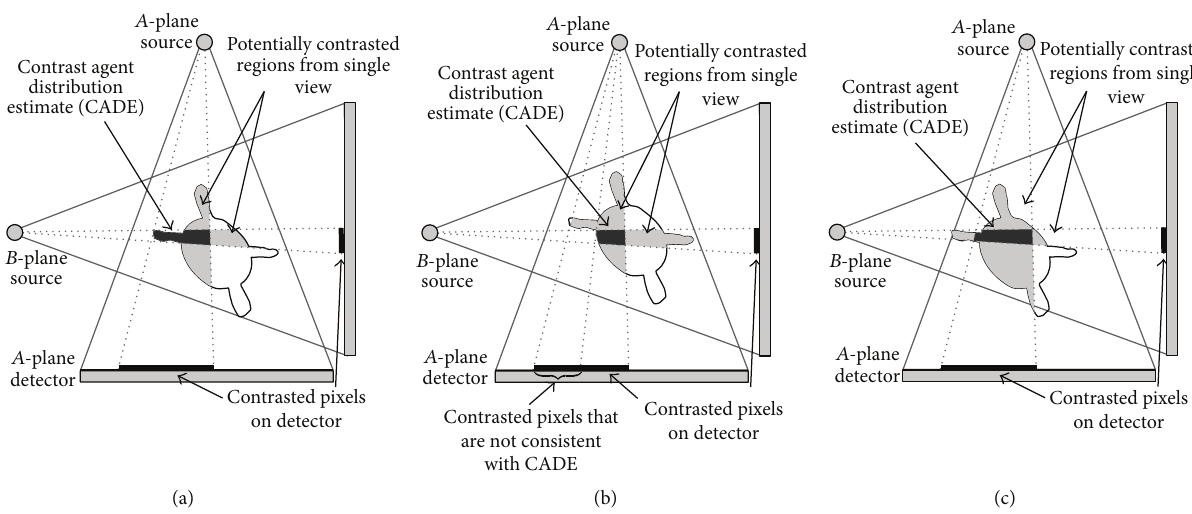
Figure 4: Top-down view on a left atrium and associated contrast-enhanced projections showing a correct registration (a) and two misregistrations (b) and (c). When looking at the contrasted pixels on each detector independently, all LA positions seem to be feasible. Considering the LA position in (b), the area, which can contain contrast agent according to the combination of both detectors, is partially outside the LA. For the CADE, however, only contrast agent inside the LA is considered. So the registration in (b) gives rise to contrasted pixels on the A-plane detector that cannot be explained by the CADE. This will result in a low CADE value and indicate misregistration. There exist, however, also misregistrations that can lead to a consistent CADE as shown in (c). This is why a combination of CADE and edge-based methods yields improved results.